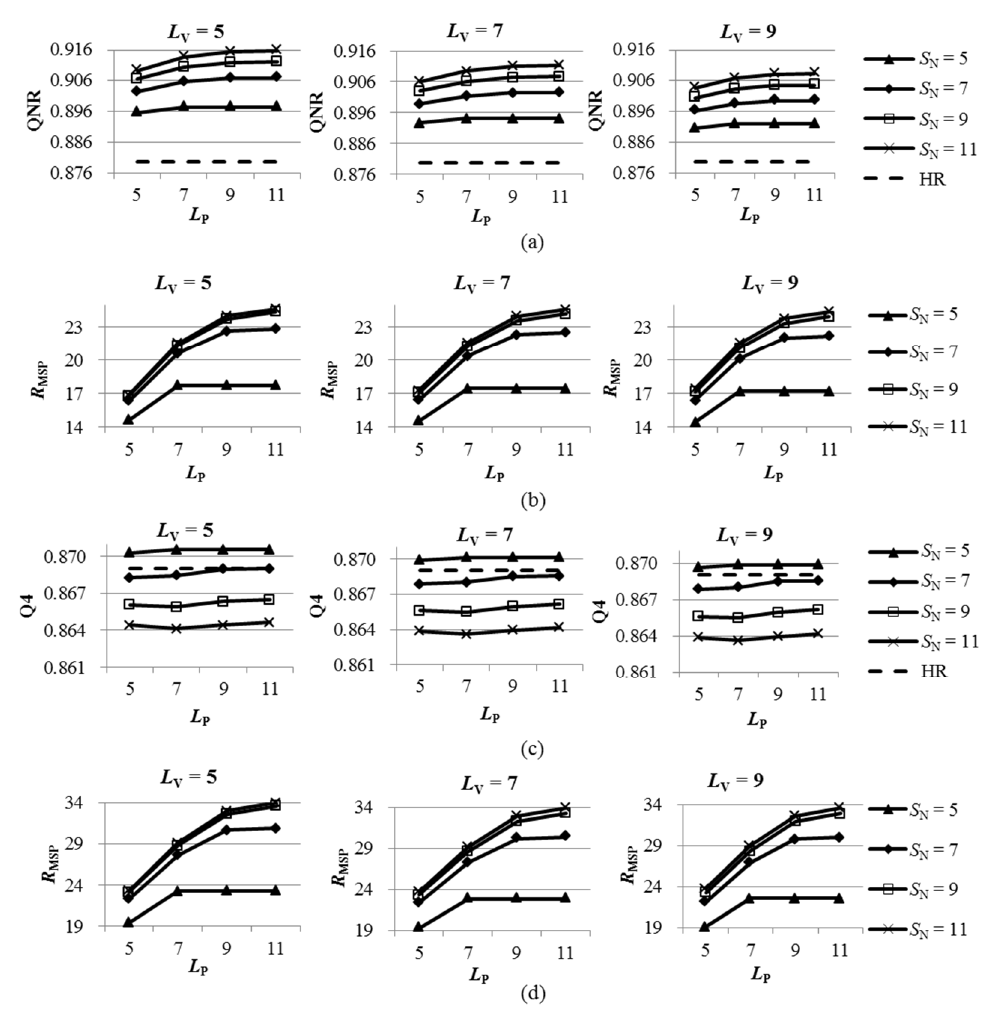
Figure 11. ( a ) QNR and ( b ) ratio of un-mixed MSPs ( R MSP ) for the UHR-fused images produced from the original IKONOS dataset; ( c ) Q4 and ( d ) R MSP for the UHR-fused images produced from the degraded IKONOS dataset.